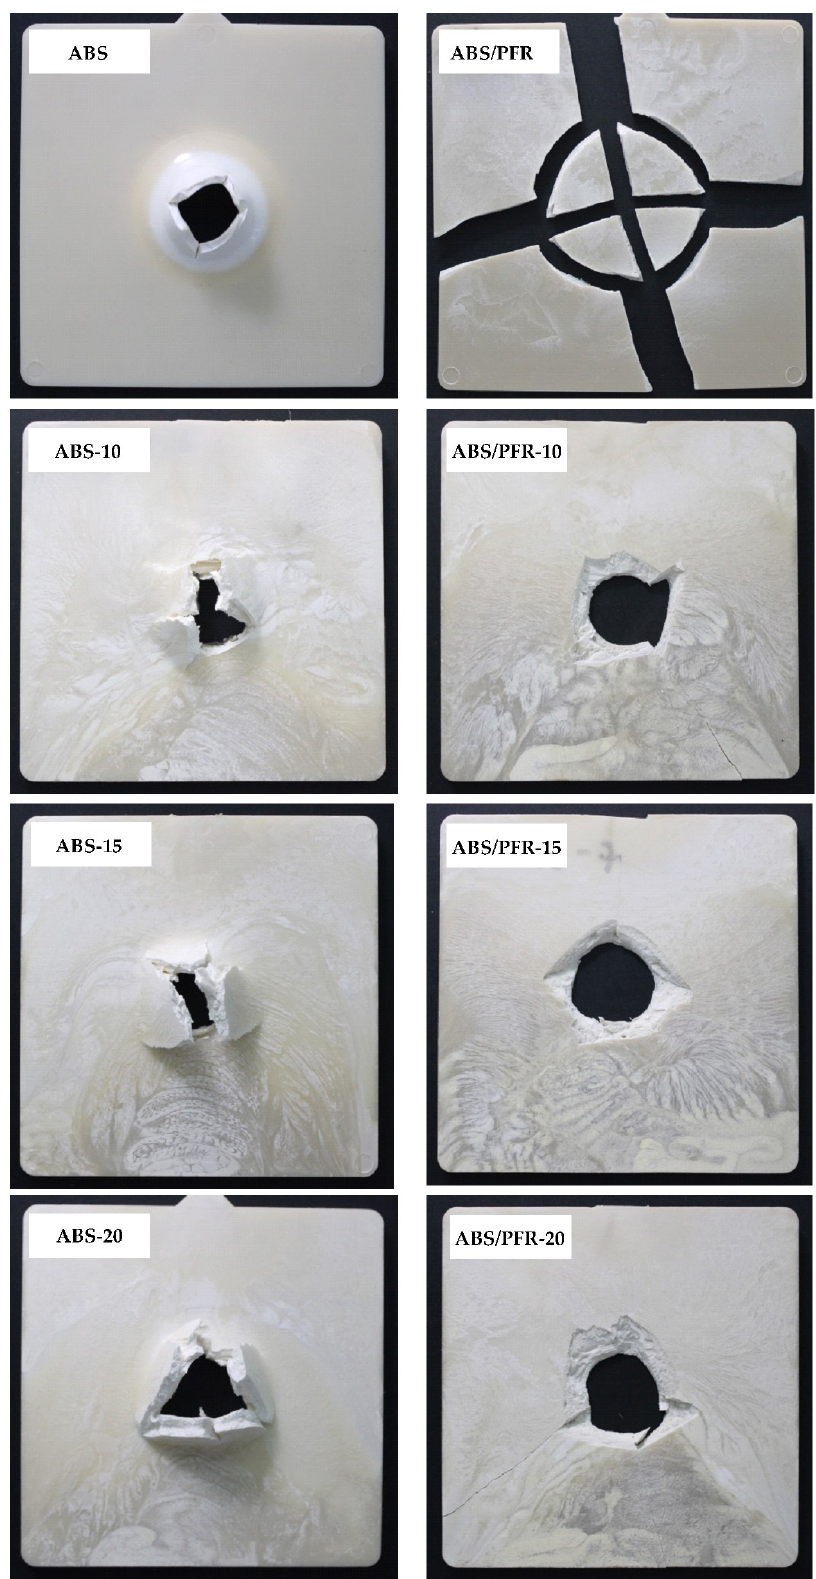
Figure 11. Characteristic images of unfoamed and foamed ABS and ABS/PFR parts after impact